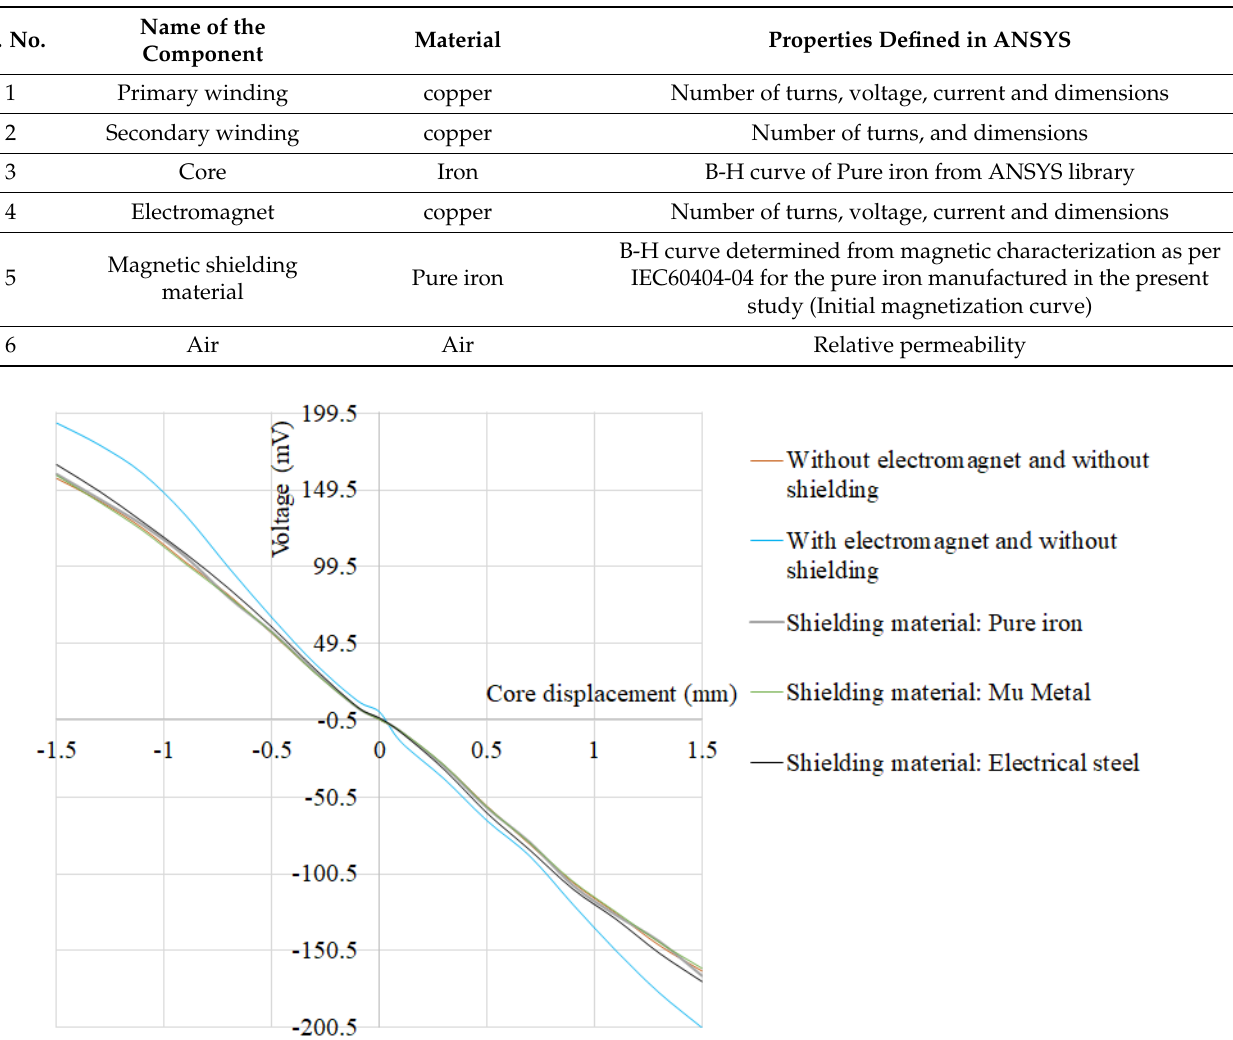
Figure 18. Secondary coil differential voltage along the displacement of the LVDT core.